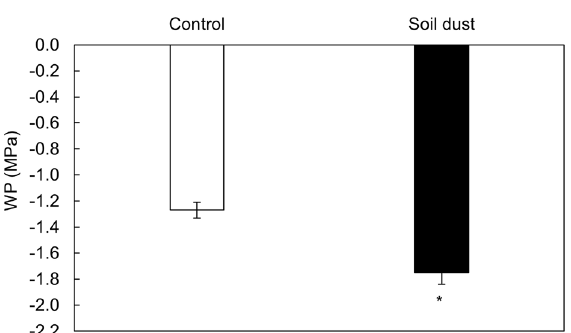
Figure 1. The effect of soil dust application on leaf water potential (WP) in lettuce grown under hydroponic conditions. Significant differences between treatments are indicated by asterisks (ANOVA; Fisher’s LSD test; p ≤